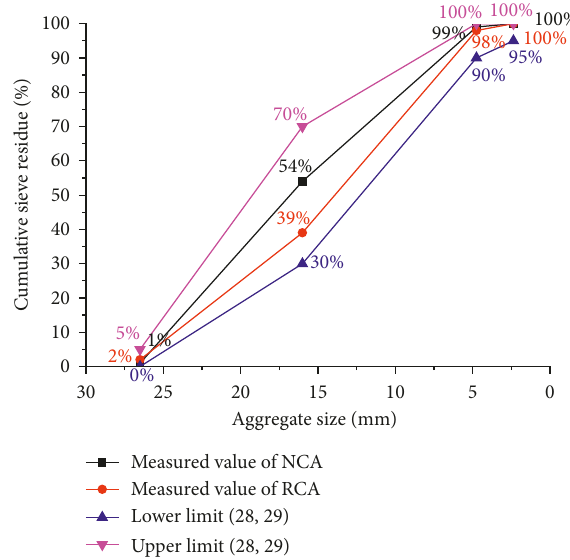
Figure 1: The grading curves of the NCA and